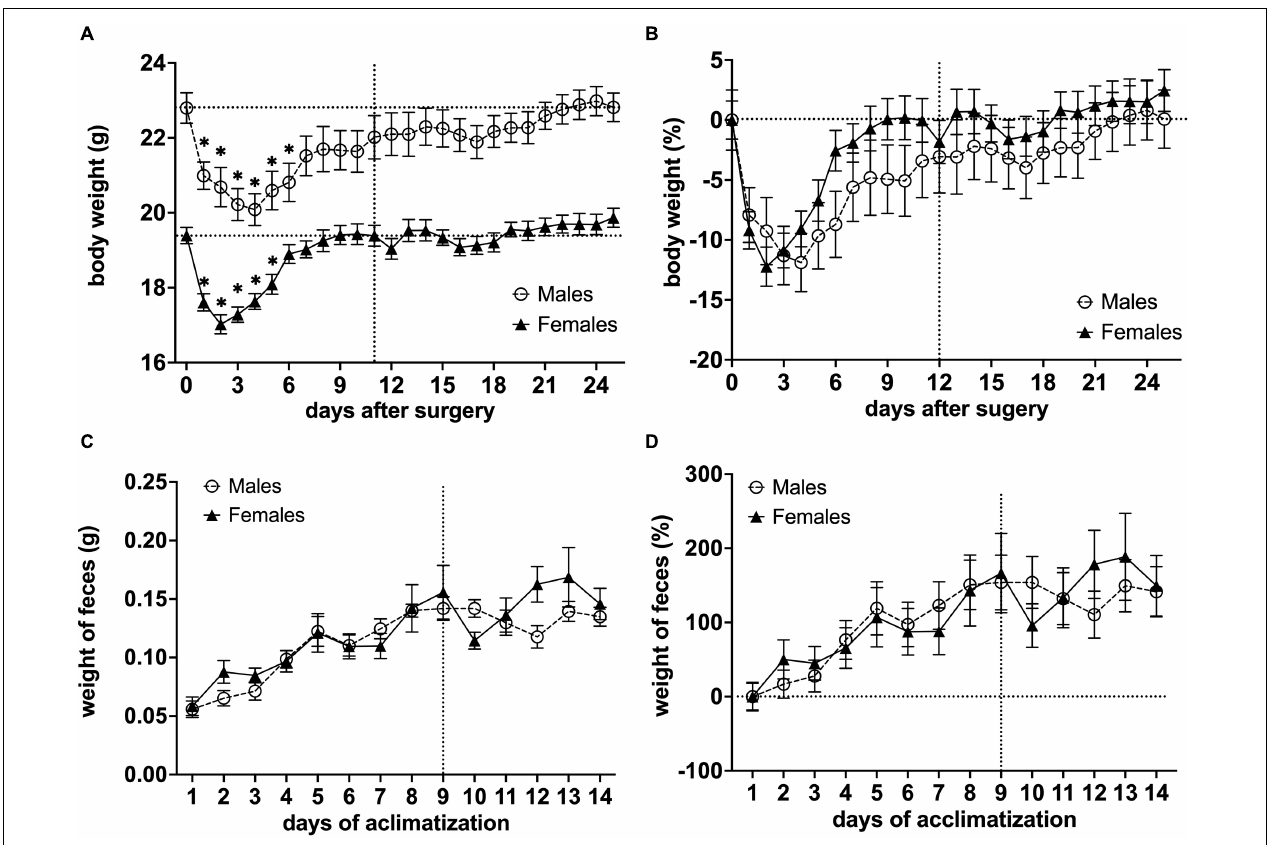
FIGURE 5 | Effects of surgical procedures and awake MRI habituation on mouse body weight fluctuations and weight of fecal boli throughout the awake MRI habituation. (A) Mean body weight of males and females ( ∗ P < 0.05 vs. body weight after surgery with day 1 as a control in a Dunnett’s test). (B) Relative change in mean body weight with Day 0 used for baseline correction. Note that the vertical line on (A,B) indicates the start of awake MRI acclimatization. The horizontal lines on (A) indicate the mean body weight post-surgery for males and females, respectively, while the horizontal line on (B) indicates the corrected baseline (0%). (C) Mean weight of fecal boli during habituation period. (D) Relative change in mean weight of fecal boli with Day 0 used for baseline correction. Note that the vertical lines on (C,D) indicate when awake MRI habituation length reached the maximum (180 min), while the horizontal line on (D) indicates corrected baseline